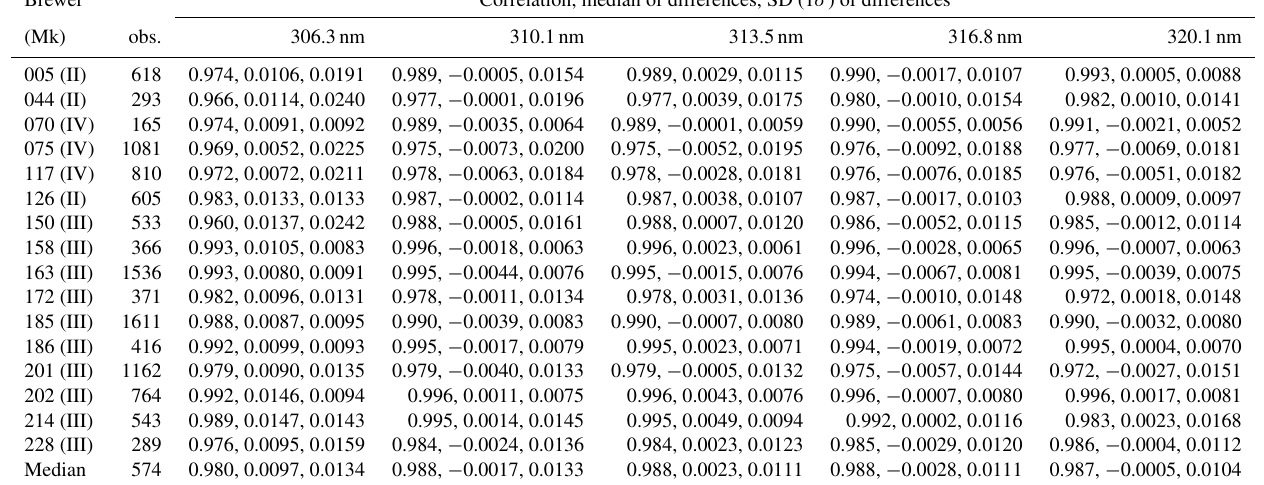
Table 2. Comparison between the AOD data of the Brewer and UVPFR instruments at the tenth intercomparison campaign of the RBCC-E. We use data from observations within 1min and show the same statistics as in Table 1. Correlation, median of differences, SD (1 σ ) of